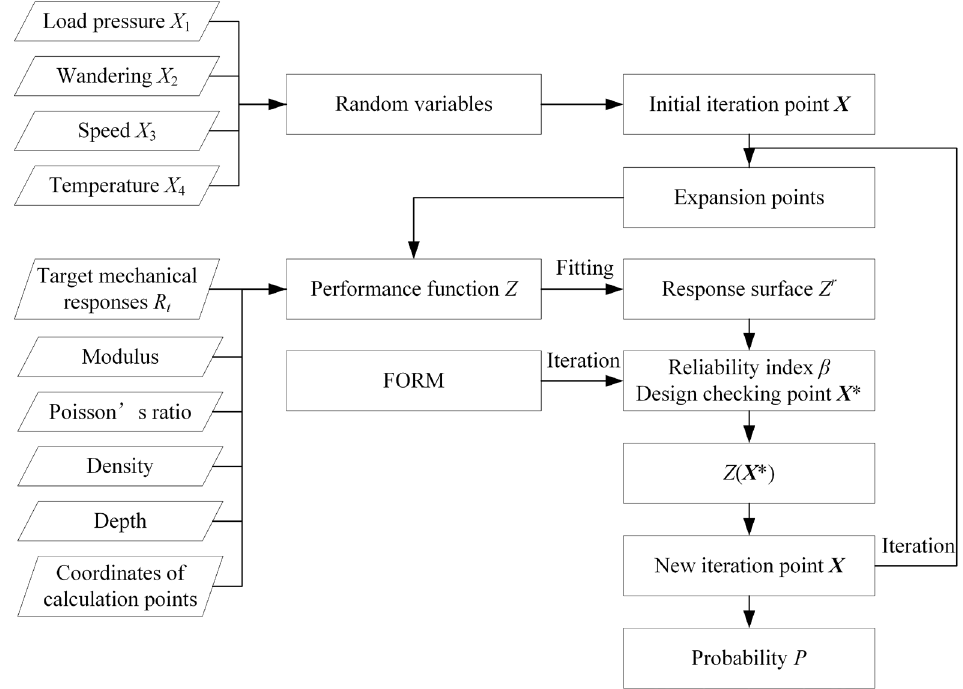
Figure 2. Flowchart of the probability calculation.